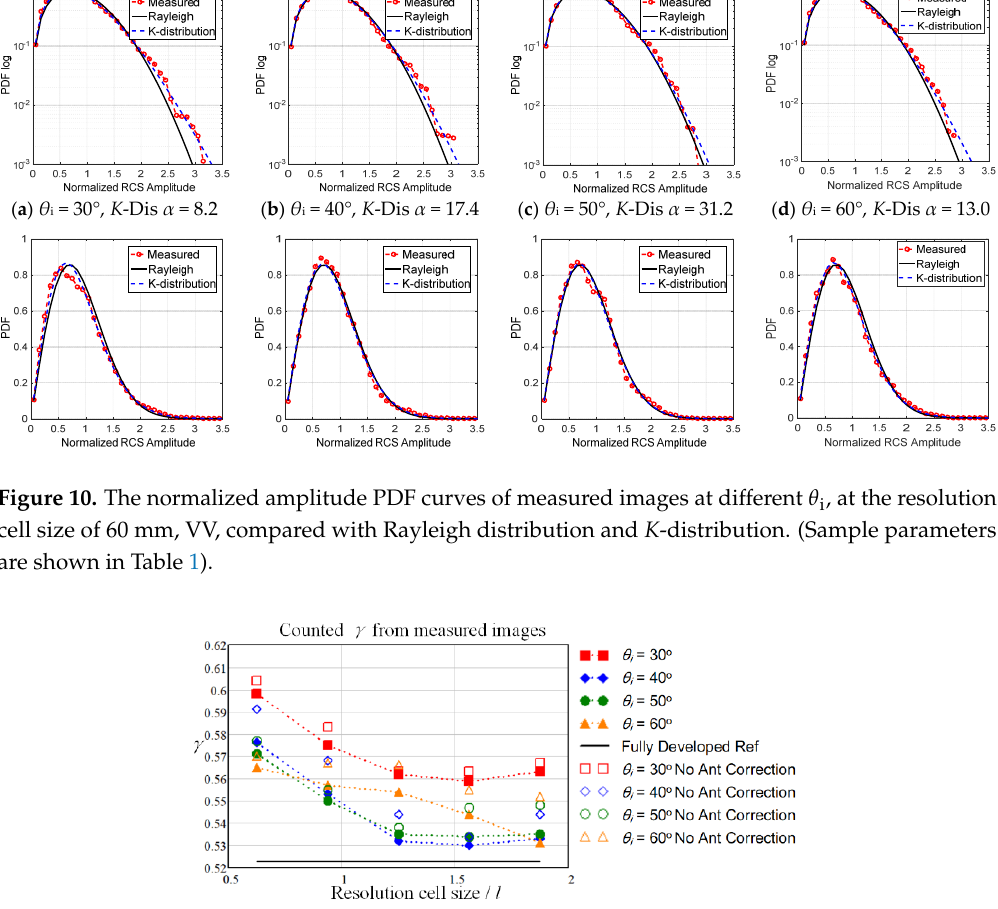
Figure 11. The computed γ value versus resolution cell size in case of different θ i from the measured images, VV. “No Ant Correction” denotes for the γ values from images without the antenna pattern correction procedure. (Sample parameters are shown in Table 1).